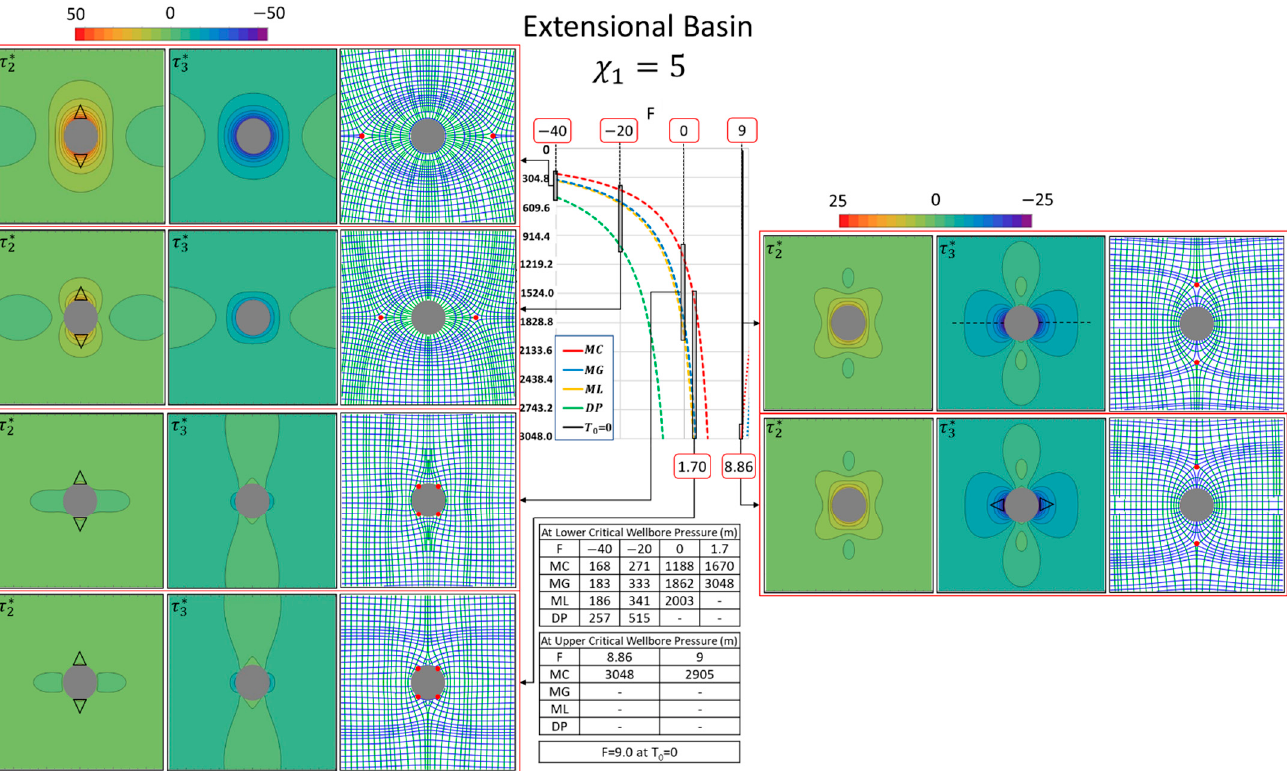
Figure 11. Dimensionless deviatoric stress magnitudes and trajectories for the extensional basin (normal faulting) case at upper-bound (left-hand side) and lower-bound shear failure (right-hand side). For the zero tensile strength, tensile failure will occur at F = 9.0. The color indices above the magnitude plots indicate the local stress intensity is normalized by the intermediate (compressional) far-field stress (see Appendix B.5). The triangles and dashed lines on the magnitude plots of the maximum principal stress at shear failure and of the minimum principal stress at tensile failure show the expected locations of failure. The blue and green curves, and the red dots in the stress trajectory plots represent the maximum and minimum principal stress trajectories, and the neutral points, respectively. The tables beneath the F curves show the depths for each F value calculated by the Mohr–Coulomb (MC), Mogi–Coulomb (MG), modified Lade (ML), and Drucker–Prager (DP) failure criteria.